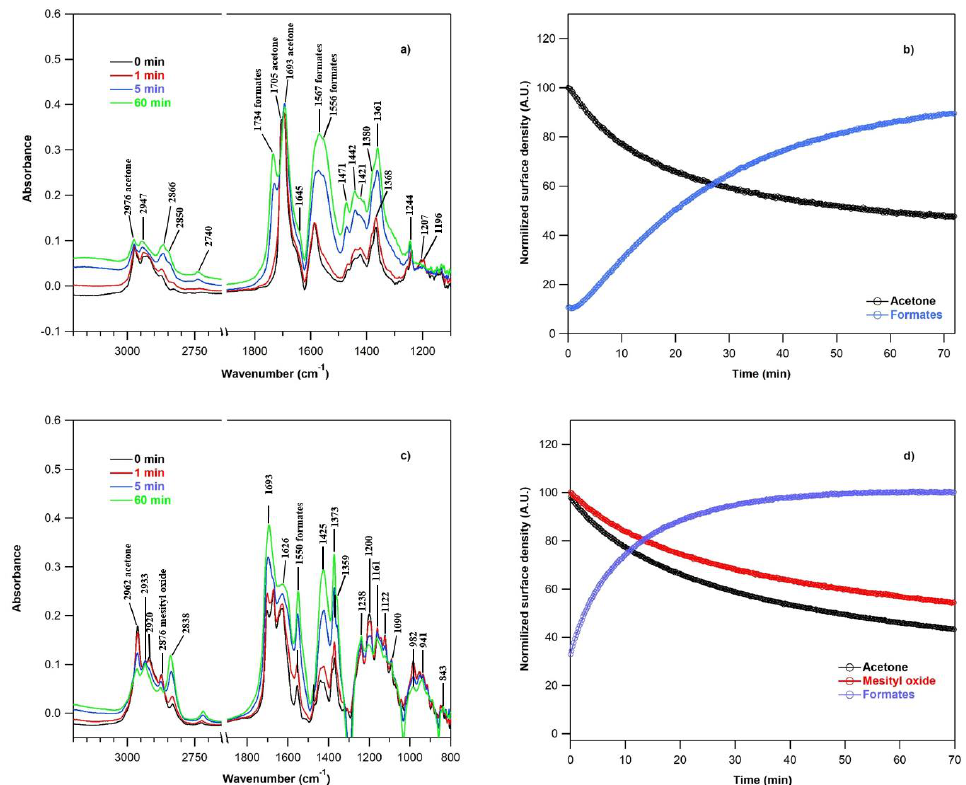
Figure 6. DRIFT monitoring of the ozonation of TiO 2 and CeO 2 , preliminarily exposed to 200 ppm acetone, 250 mL/min 20% O 2 in Ar, 294 K, and flushed under dry air. ( a ) DRIFT absorbance spectra recorded during the ozonation of TiO 2 preliminarily exposed to acetone. ( b ) Temporal profiles of adsorbed acetone and formates on the surface of TiO 2 during the ozonation. ( c ) DRIFT absorbance spectra recorded during the ozonation of CeO 2 preliminarily exposed to acetone. ( d ) Temporal profiles of adsorbed acetone and intermediates (mesithyloxide (MO) and formate) on the surface of CeO 2 during the ozonation.